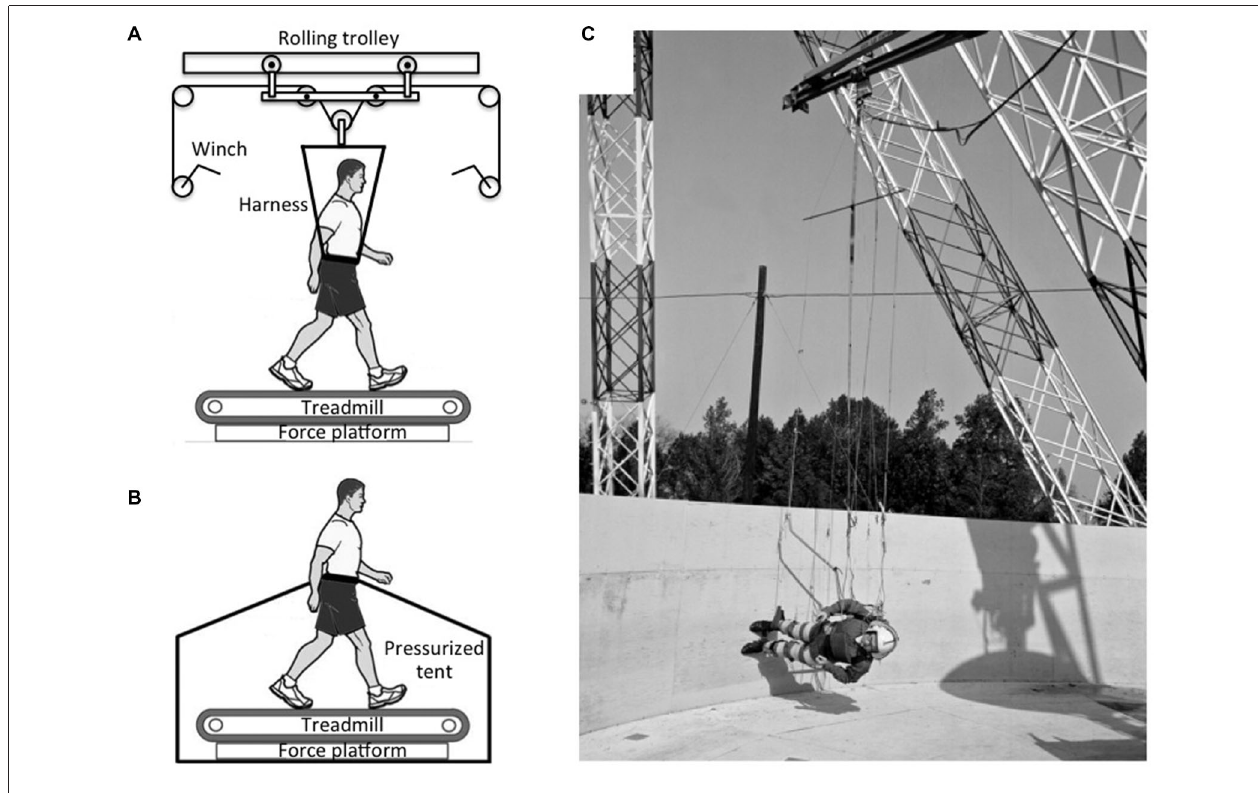
(LBPP) support that reduces weight bearing. (C) The reduced-gravity walking simulator at NASA Langley Research Center used long cables to support a subject walking on a tilted surface Photo credit: